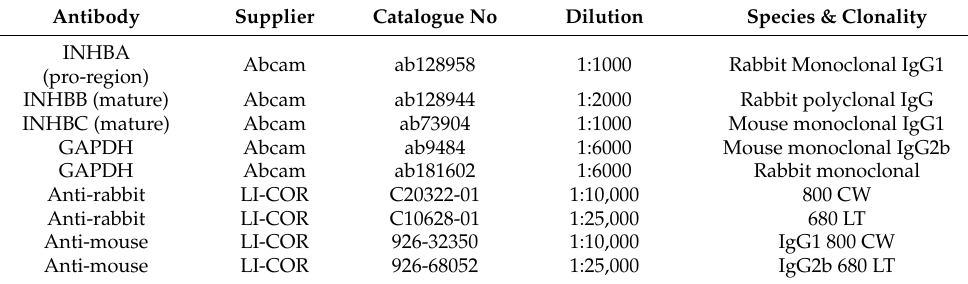
Table 2. Antibodies used for Western